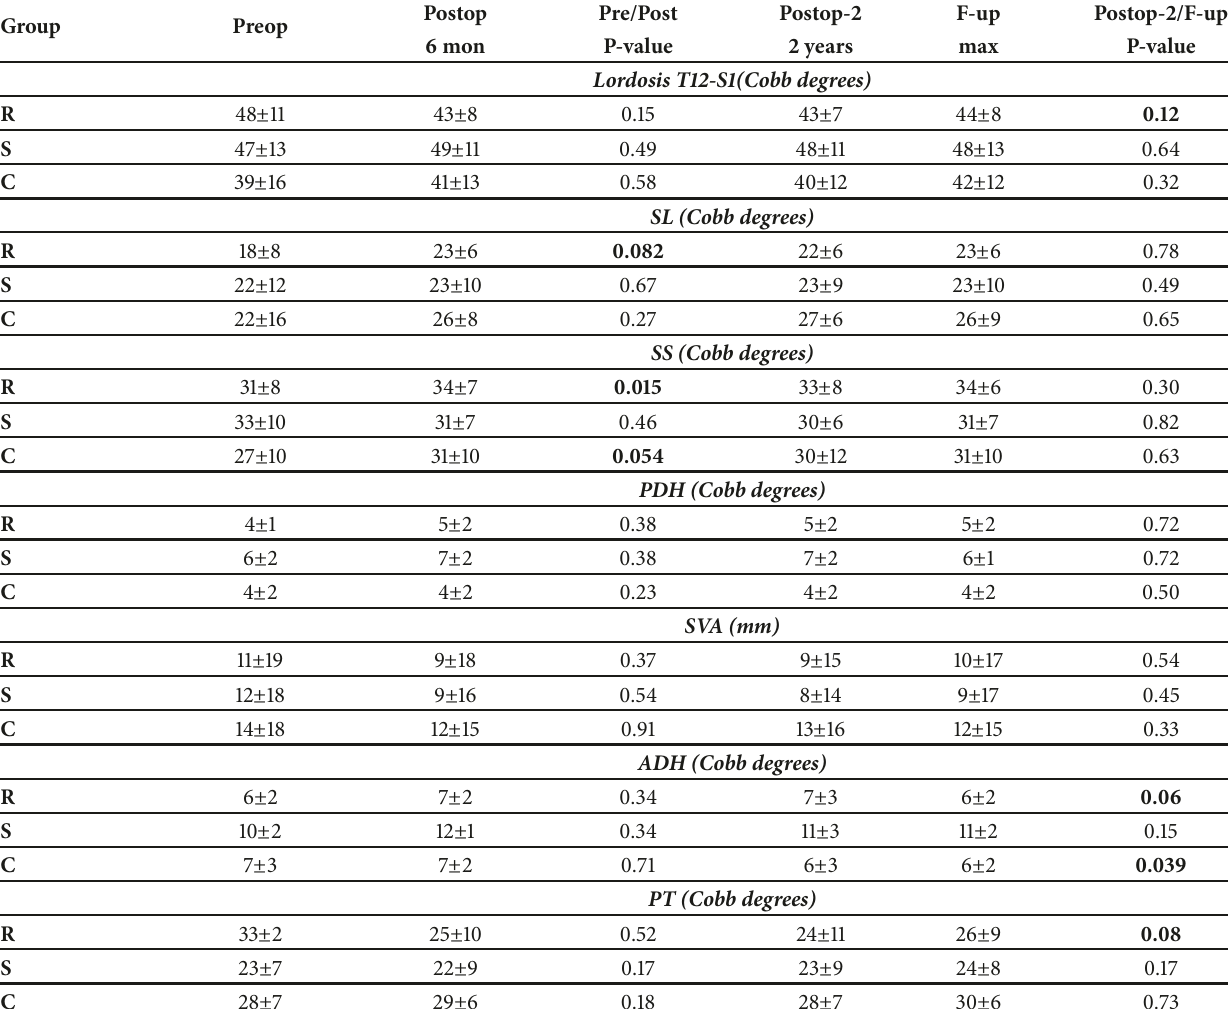
Table 7: Changes of radiographic parameters preoperatively till the last follow-up in Groups R, S, and C (paired t-test). Postop Pre/Post Postop-2 F-up Postop-2/F-up Group Preop 6 mon P-value 2 years max P-value Lordosis T12-S1(Cobb degrees) 48 ±